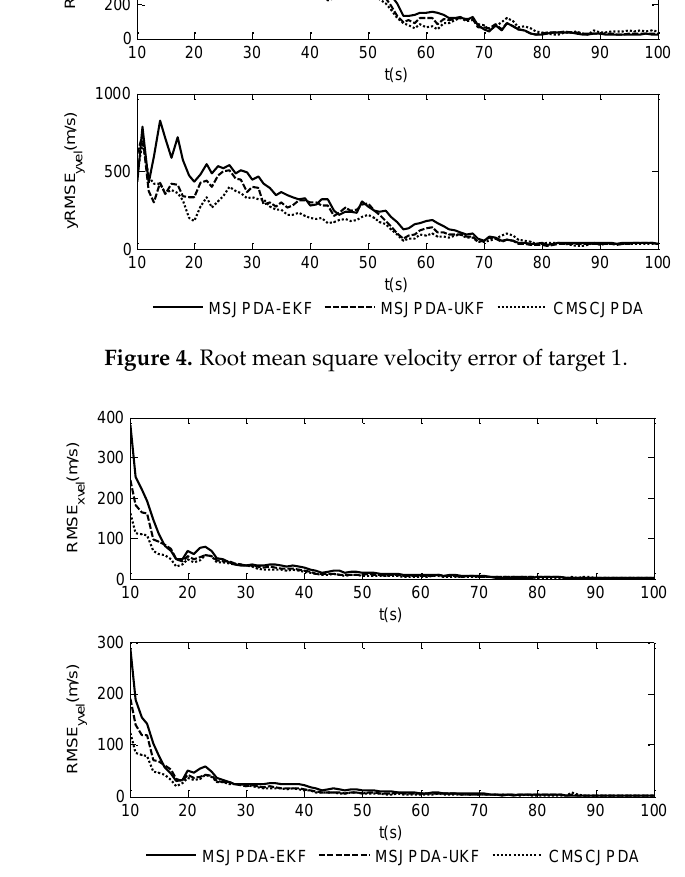
Figure 5. Root mean square velocity error of target 2.